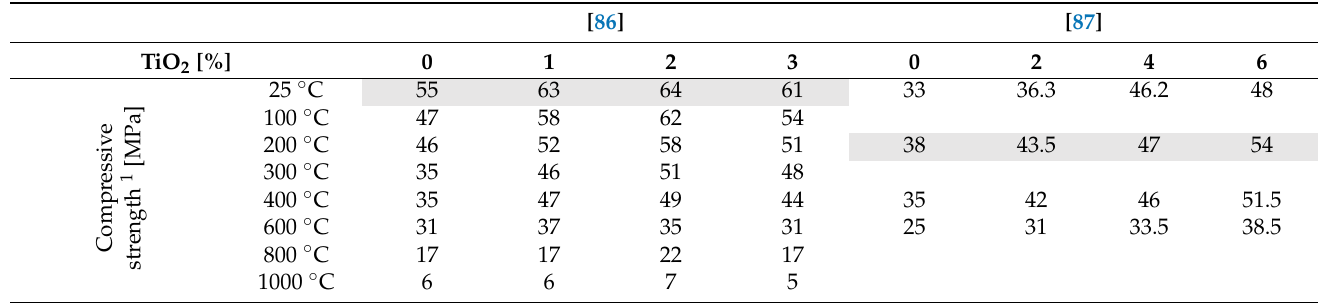
Table 9. Compressive strength values for TiO 2 —mortar/concrete specimens at high temperature.